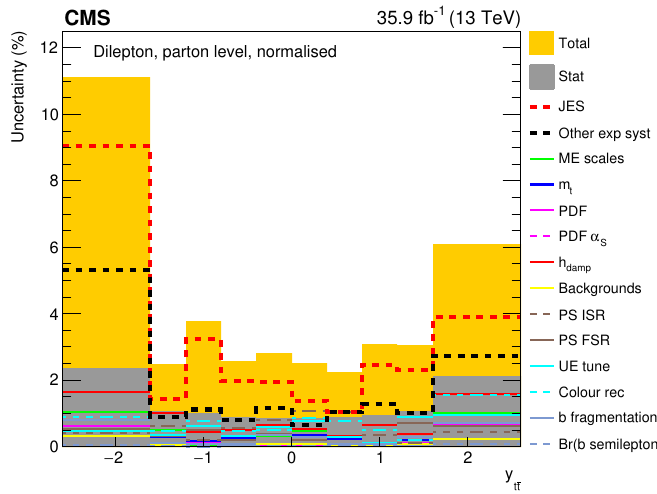
Figure 29 . The contributions of each source of systematic uncertainty to the total systematic uncertainty in each bin is shown for the measurement of the normalised tt production cross sections as a function of y . The sources a(cid:11)ecting the JES are added in quadrature and shown as a single tt component. Additional experimental systematic uncertainties are also added in quadrature and shown as a single component. Contributions from theoretical uncertainties are shown